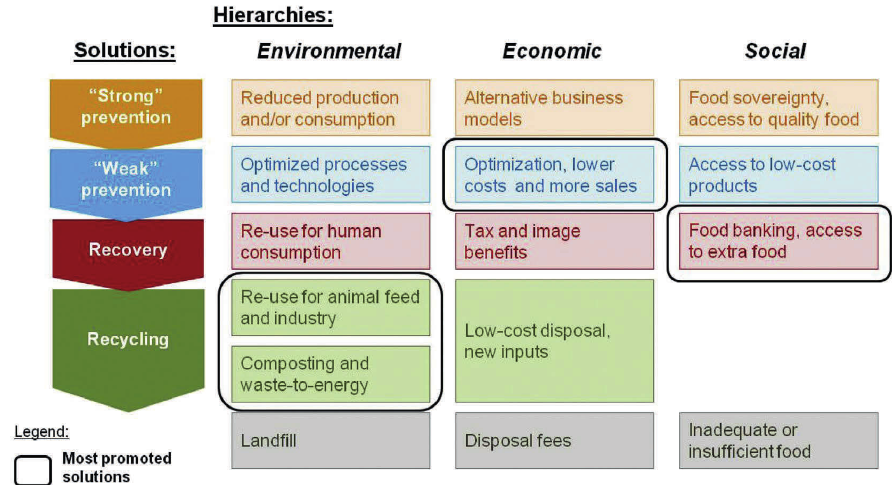
Fig. 1. Competing hierarchies for avoiding FW